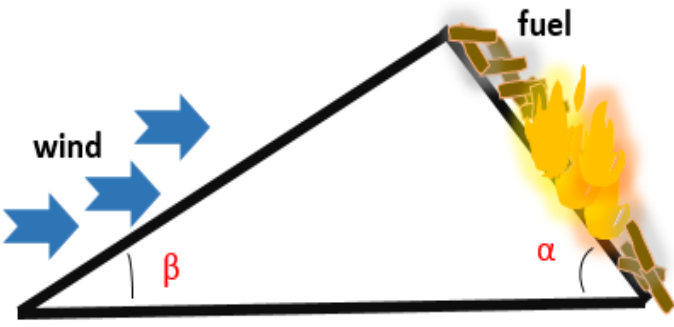
Figure 2. Point of ignition and the cross-section of the empirical ridge shape